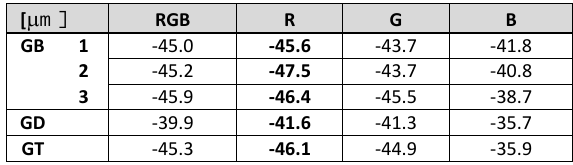
Table 4. Comparison of radial distortion correction in 1.9 mm radial distance. All units in  m. The largest correction value for each dataset is highlighted. Figure 6. Decentring distortion profile of camera GB camera 1st repeat (RGB and R – black, B – blue, G –green bands) for the individual adjustment. X axis in mm, y axis in  m.